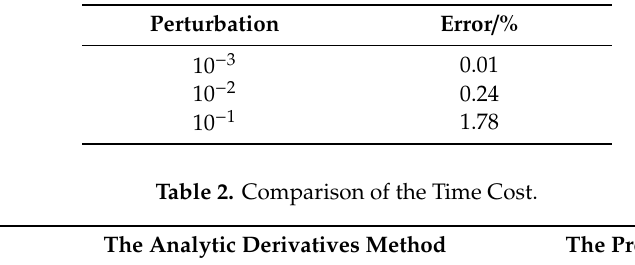
Table 1. Errors between Proposed Method and Analytical Derivatives.